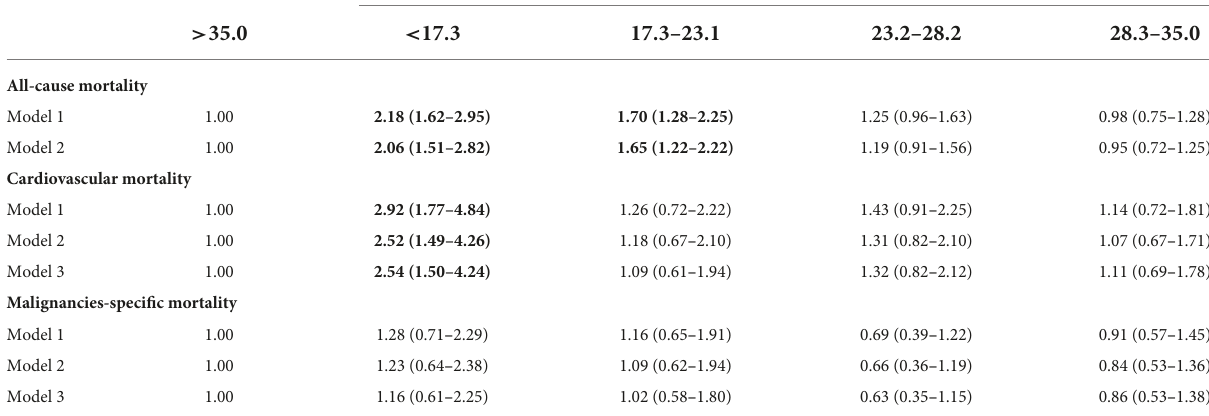
Serum 25(OH)VD (ng/mL)